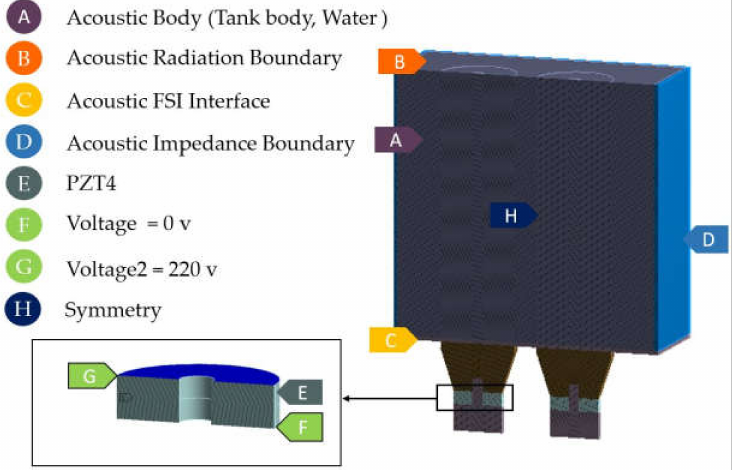
Figure 8. Boundary conditions.